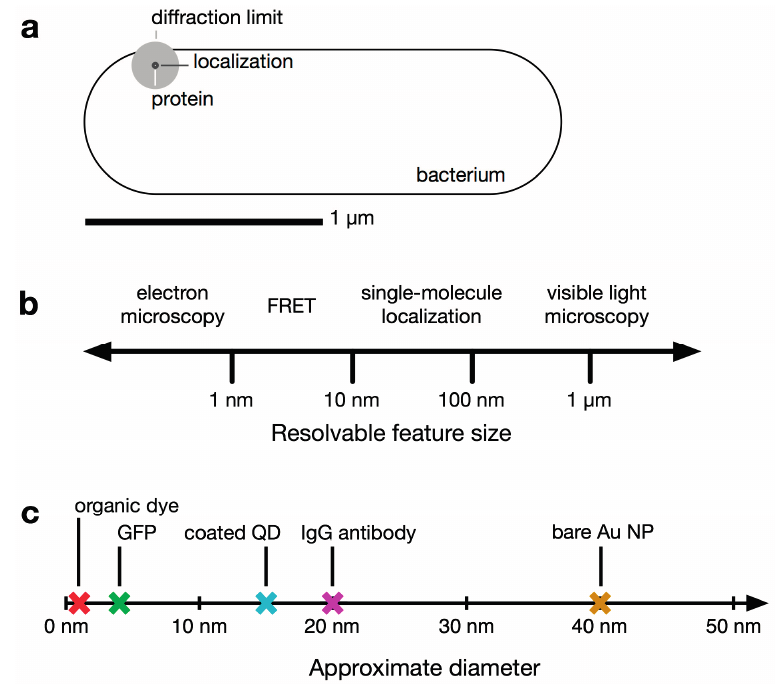
Figure 1. Relevant size scales in subcellular imaging of bacteria. ( a ) Comparison of the size of a V. cholerae bacterial cell and the diffraction limit of light. A small fluorescent protein appears blurred to the diffraction limit (~200 nm, gray circle). Single-molecule imaging localizes the fluorophore with greater precision (~30 nm, black circle); ( b ) Resolvable size scales (log scale) using several common microscopy techniques; ( c ) Approximate diameters of an organic fluorophore, a fluorescent protein (GFP [8]), a coated quantum dot (QD; [9]), an immunoglobulin (IgG) antibody [10], and a 40-nm gold nanoparticle